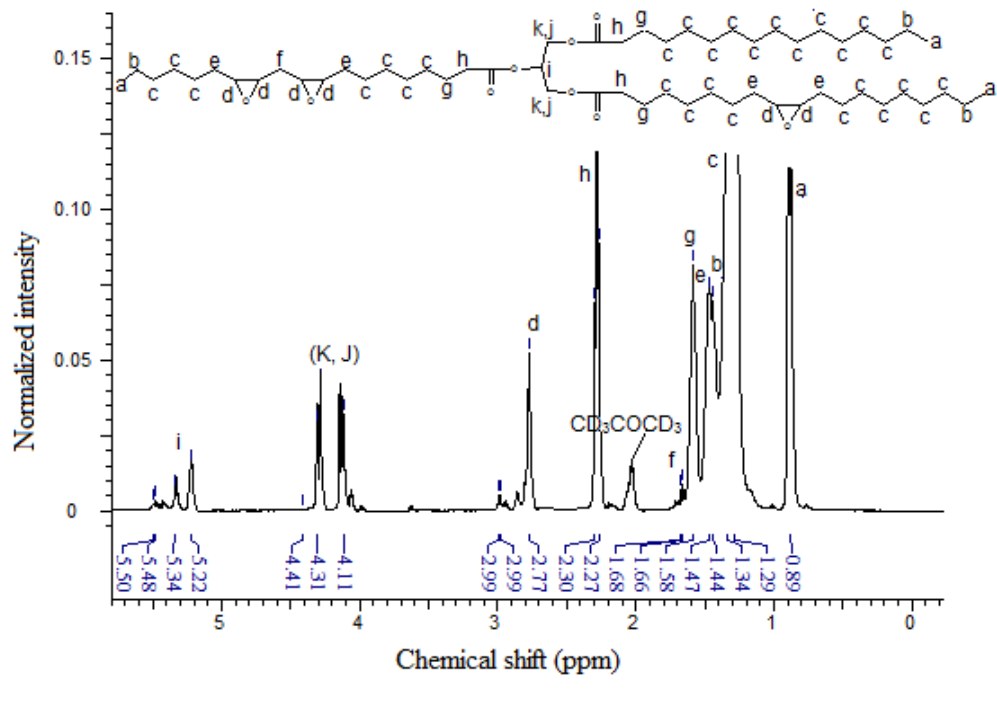
Figure 4. 1 H-NMR Spectrum of